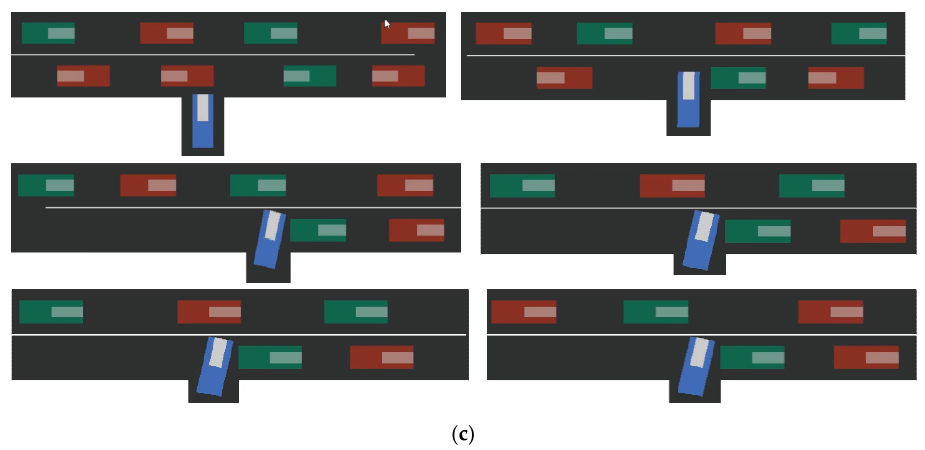
Figure 8. Process of the self-driving car making a full right-turn on the upper lane. ( a ) self-driving car successfully makes a full right-turn on the upper lane at time t . ( b ) Self-driving car collide at time t + 1. ( c ) Self-driving car overtime at time t + n .